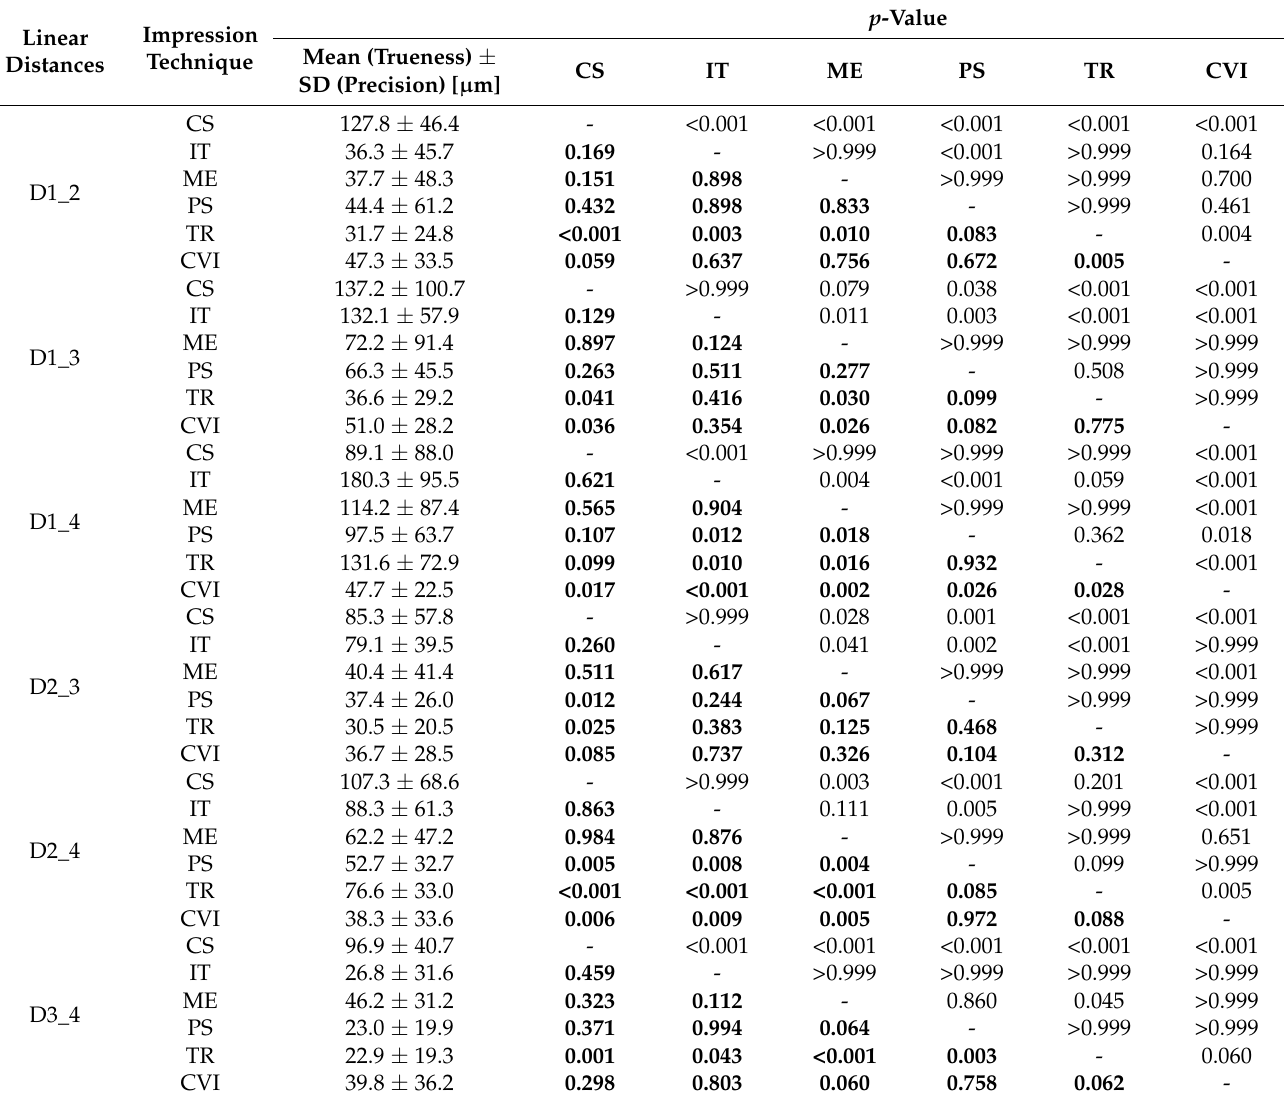
Table A2. Deviations (mean ± standard deviation (SD) [ µ m]) of the linear distances (D1_2, D1_3, D1_4, D2_3, D2_4, D3_4) of six impression techniques (CS = CS 3800, IT = iTero Element 5D, ME = Medit i700, PS = Primescan, TR = Trios 4, CVI = conventional impression) for Group B (young fully dentate) and statistical analysis for trueness (upper right part) and precision (lower left part, presented in bold type) according to ISO 5725 [6].